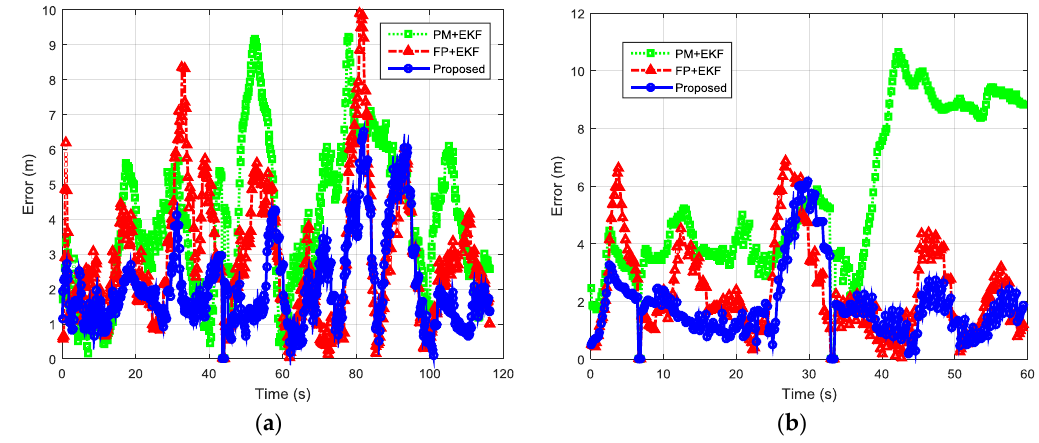
Figure 16. Localization errors of two indoor trajectories with sparsely distributed BLE beacons using the proposed method, PM + EKF and FP + EKF: ( a ) Trajectory I; and ( b ) Trajectory II.